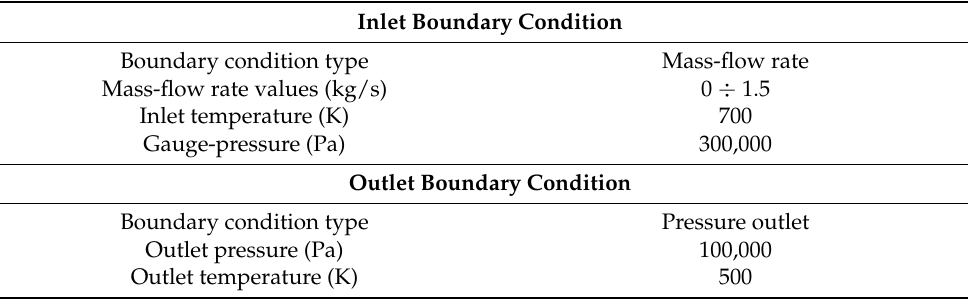
Table 4. The parameters of the boundary conditions.